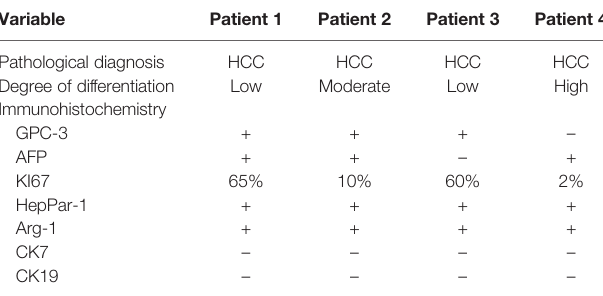
TABLE 3 | Pathological information of four patients downstaged to surgery.